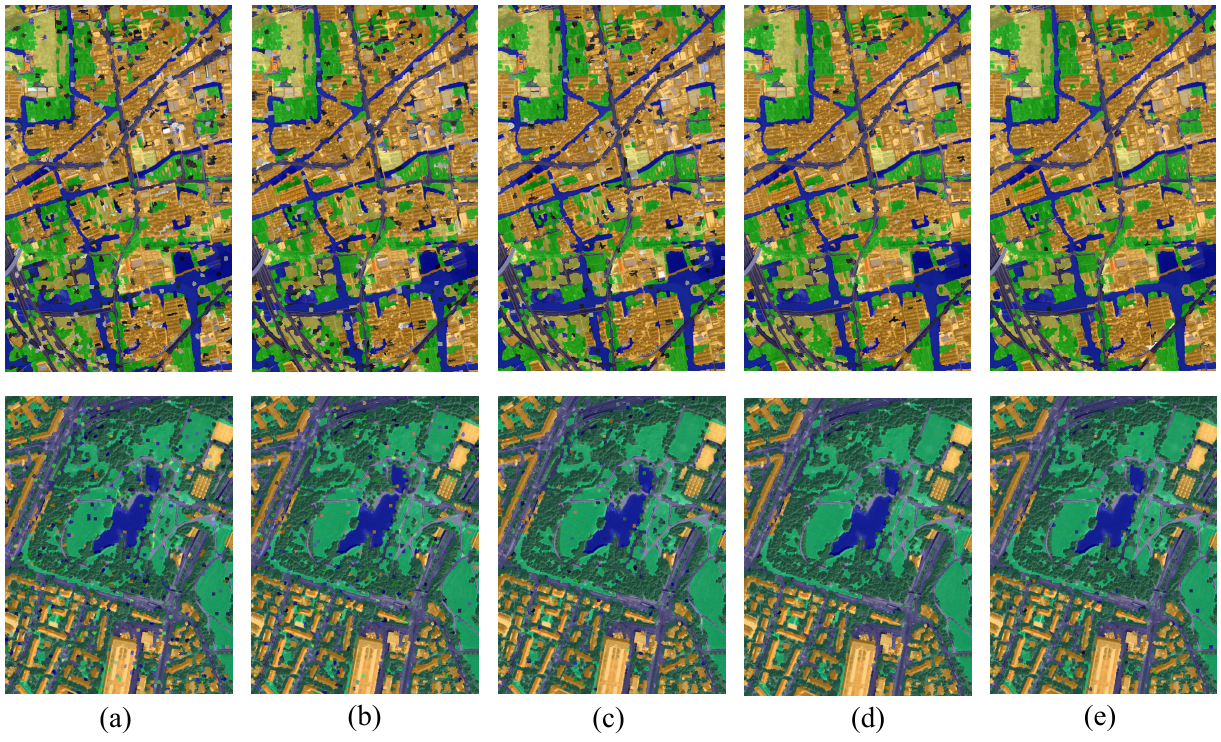
Figure 10. Classification of GF and QB with different semantic ranges, where ( a – e ) are under 9, 16, 20, 25 and 36 semantic ranges,